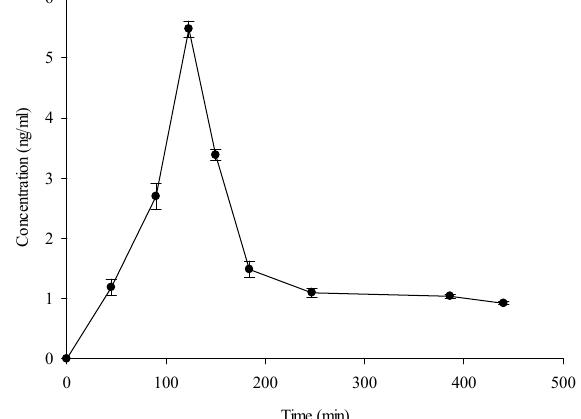
Figure 1. Representative chromatograms of plasma ( A ) and urine ( B ) samples acquired at 280 nm. DOPAC, 3,4-dihydroxyphenylacetic acid; DOPET, 3,4-dihydroxy-phenylethanol; homovanillic acid (HVA); 4-hydroxy-3-methoxy-phenylethanol (MOPET). The plasma concentration versus time profiles of free DOPET, following ingestion of 2 cps containing 15 mg DOPET conveyed in EVOO, was analyzed by a non-compartmental approach using Phoenix-WinNonLin software (Certara, St. Louis, MO, USA). The results are shown in Figure 2.